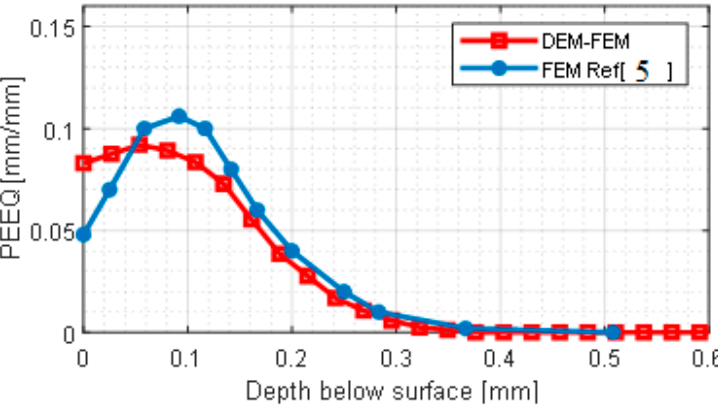
Figure 9. Residual stress profile for single-shot of 1.0 mm diameter at 50 m/s onto a target made of AISI 4340. Showing the current DEM-FEM result and FEM result recreated from the literature [5].